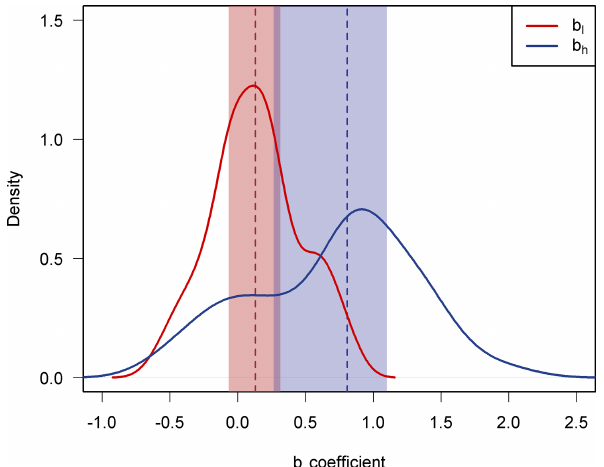
Figure 5. Density distribution of rating exponents (following Eq. 2) for the low flow ( b l ) and high flow ( b h ) regime. The blue and red vertical dashed lines indicate the median values; the blue and red shaded areas indicate the 25th and 75th percentile of both rating